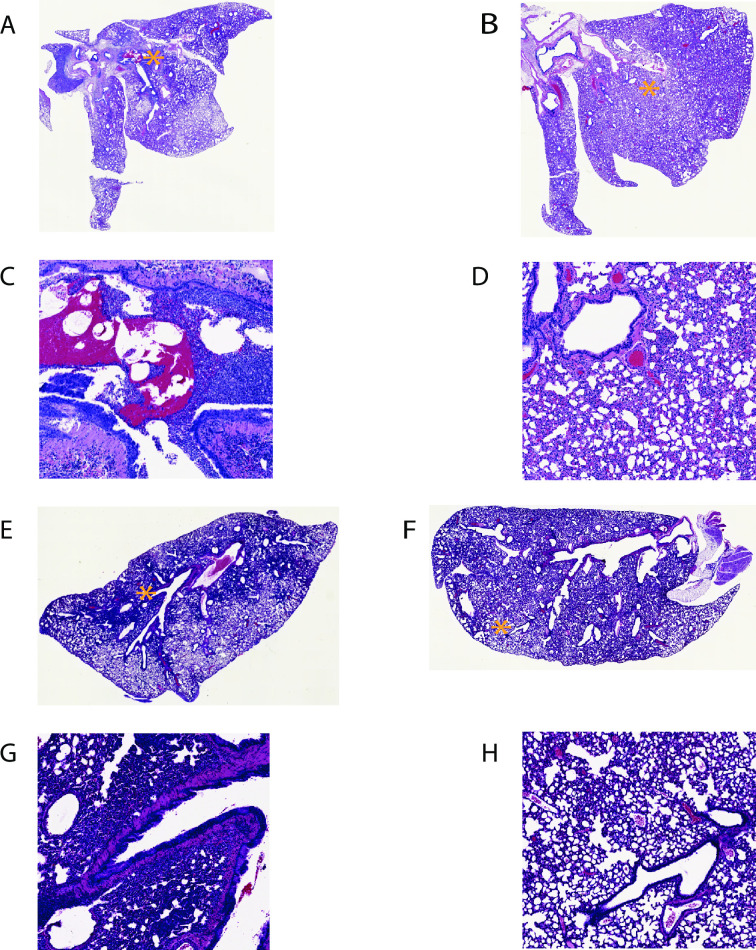
SARS-CoV 2 lung pathology.Representative histological images of SARS-CoV-2 infection in control and vaccinated hamster lungs. A and B, low magnification images, day 3 p.c. lungs. A: FILORAB1 control, B: CORAVAX vaccinated. C and D, high magnification of A and B detailing specific pathological features, location indicated by asterisks on low magnification images. Infiltration of parenchyma and airways by mononuclear inflammatory cells is prominent in control animal. Notable improvement in airway infiltration observed in vaccinated animals. Varying degrees of consolidation and septal thickening are present in control and vaccinated animals. E and F, low magnification images, day 15 p.c. lungs. E: FILORAB1 control, F: CORAVAX vaccinated. G and H, high magnification of E and F detailing specific pathological features, location indicated by asterisks (*) on low magnification images. Significant airway infiltration is absent in all animals, but other aspects of inflammatory pathology persist, such as epithelial hyperplasia Overall consolidation improved in vaccinated animals but did not reach statistical significance.